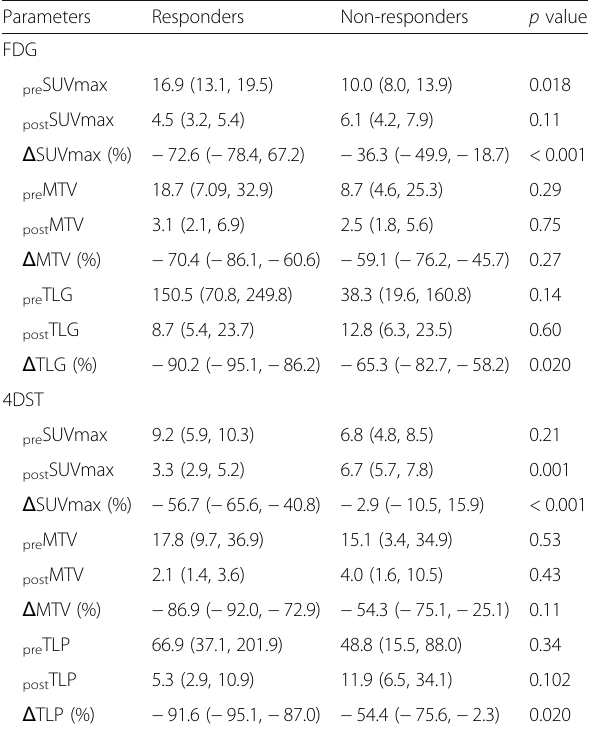
Table 3 FDG and 4DST PET parameters pre- and post-neoadjuvant therapy, comparing between responders and non-responders (median, (interquartile